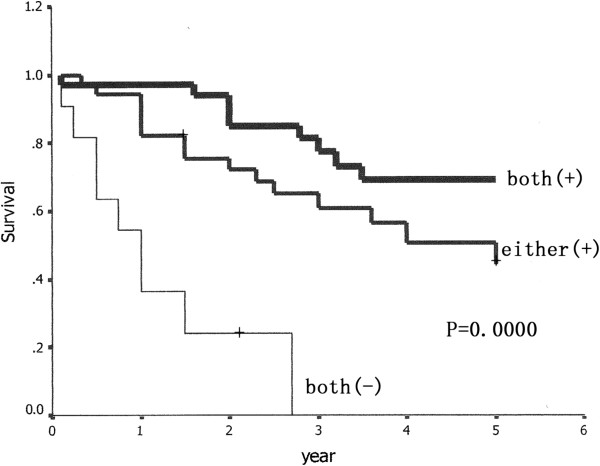
Patients with the expression of both CLDN 1 and CLDN10 had a better 5-year overall survival than those with either and neither expression of the two factors (P = 0.0000). Both (+): Both CLDN 1 and CLDN10 were positively expressed. Either (+): Either CLDN 1 or CLDN10 was positively expressed. Both (−): Neither of the two factors was positively expressed.